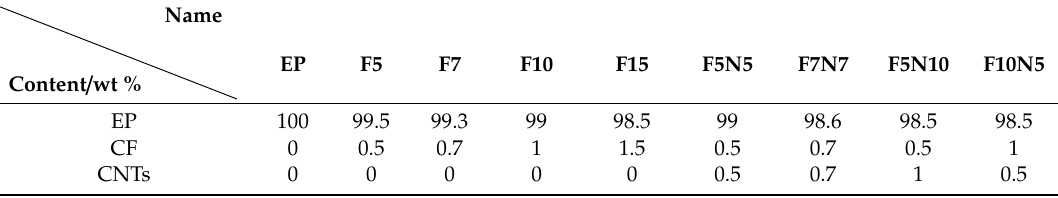
Table 1. Definition of di ff erent samples with di ff erent